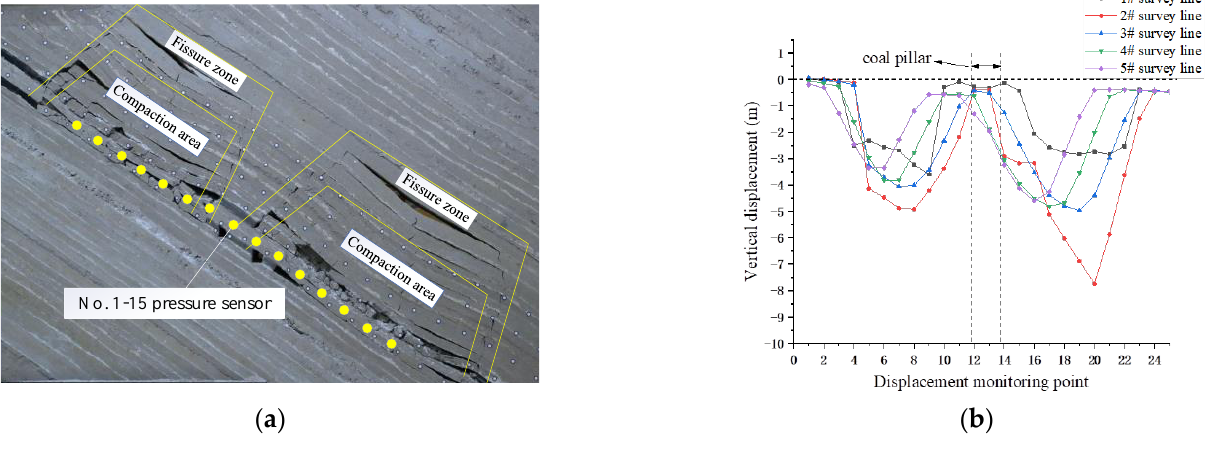
Figure 7. Migration characteristics of overburden under repeated mining. ( a ) Distribution of overburden under double pressure relief; ( b ) vertical displacement of overburden under double pressure relief.